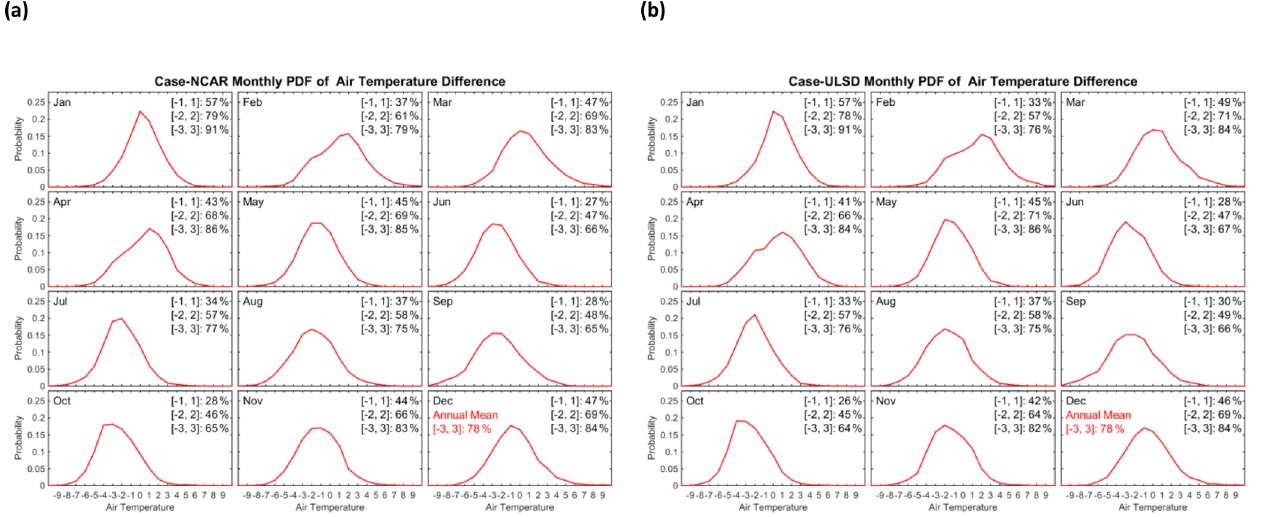
Figure 8. PDFD of 2m air temperature of Case-NCAR (a) and Case-ULSD (b) . Data source: Li et al. (2019a,